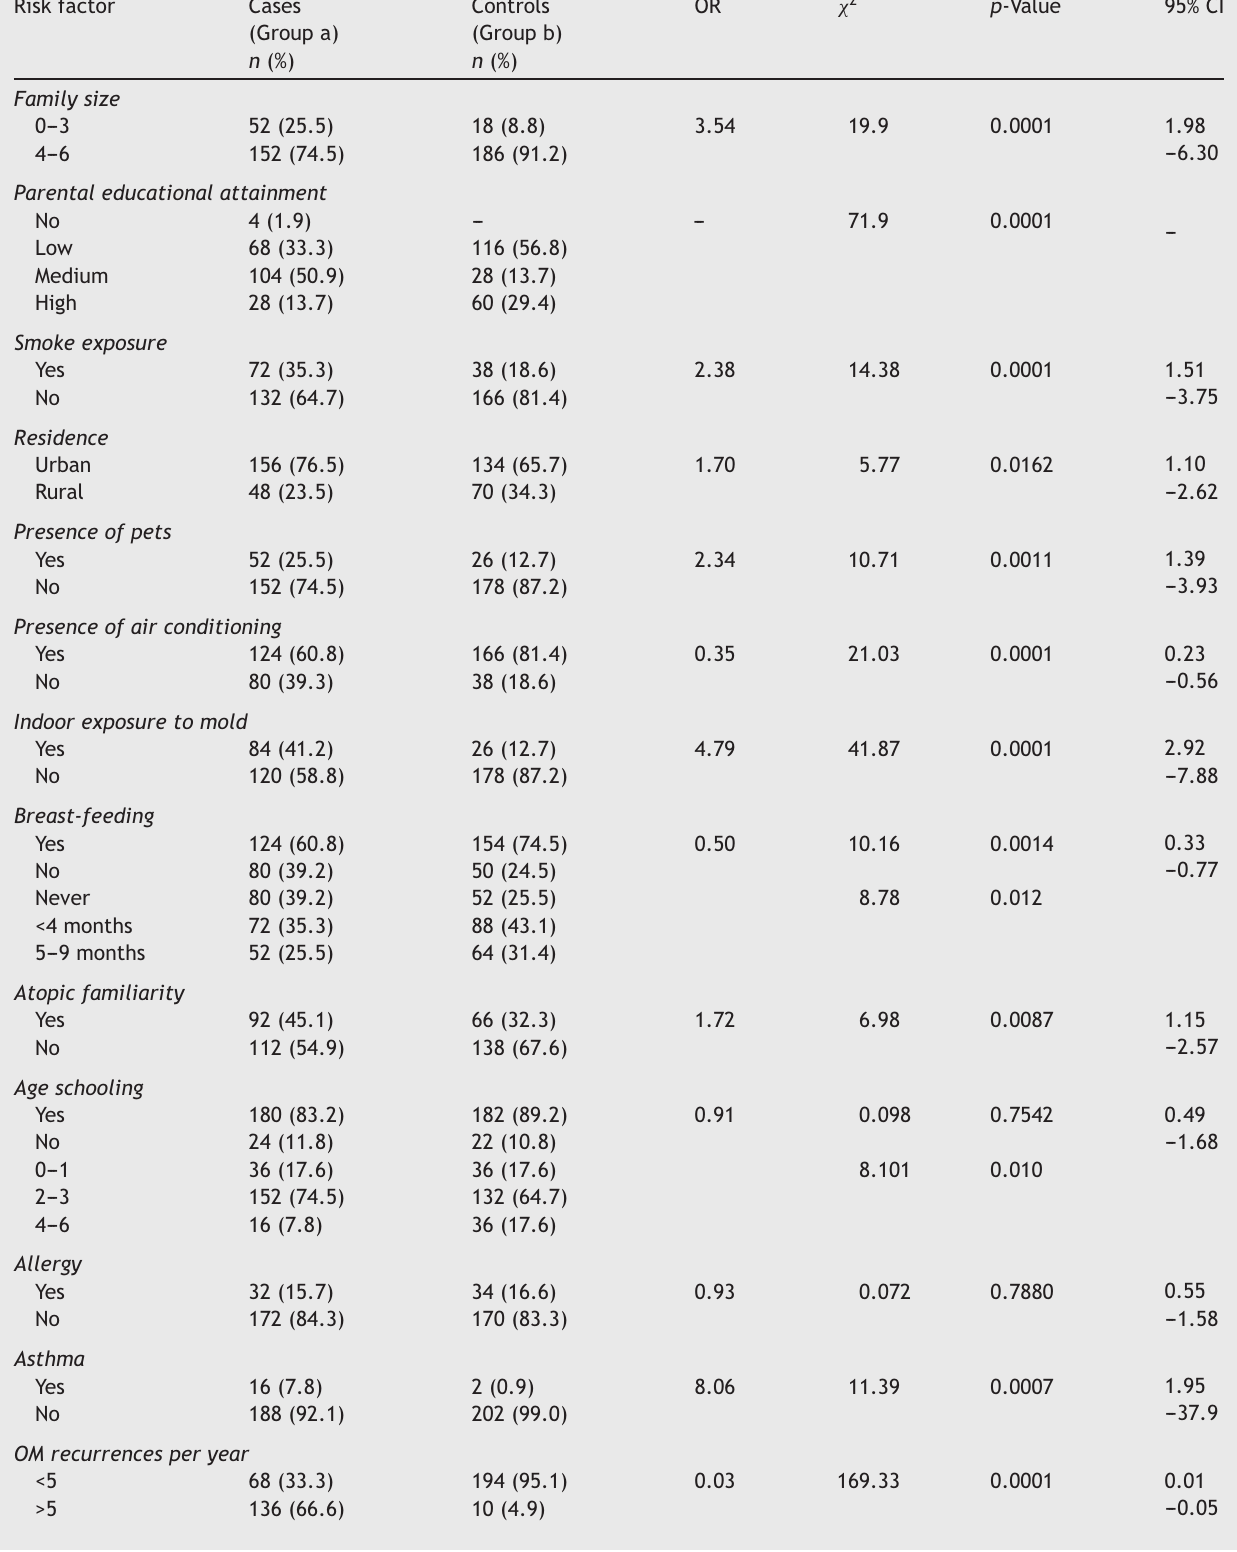
Distribution of OM risk factors in cases and controls groups: chi square ( (cid:2) 2 ), Odds Ratio (OR), p -value and 95% Confidence Limits (95%